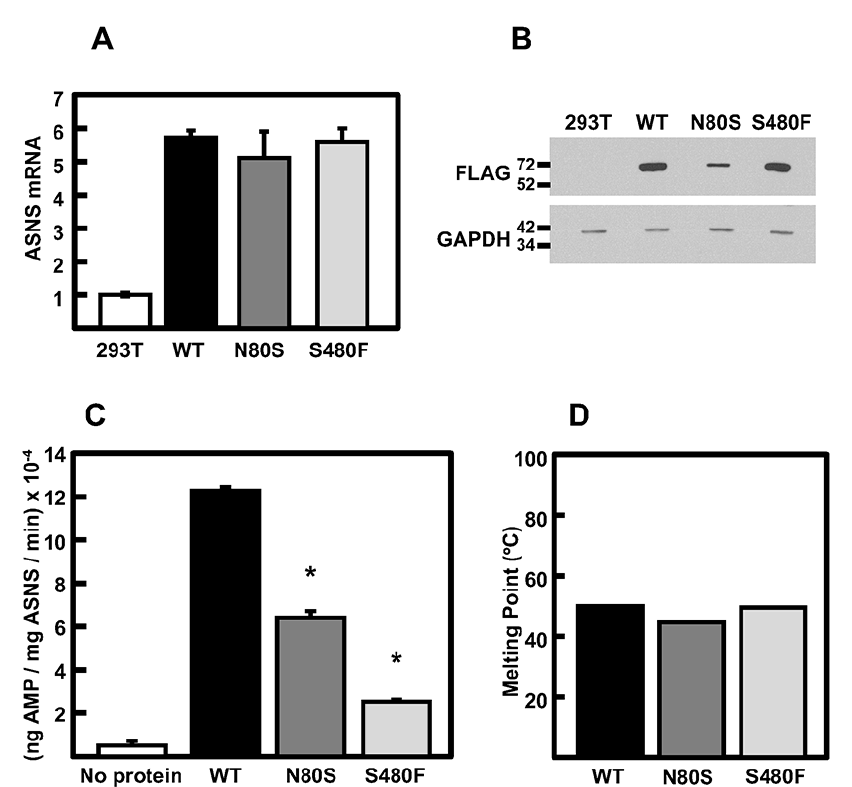
Figure 4. Enzyme activity and thermal stability of purified ASNS proteins. ( A ) ASNS mRNA levels in non-transfected HEK293T cells and in HEK293T-based cell lines stable-expressing WT, N80S, or S480F ASNS variants. The mRNA content was detected by qRT-PCR, normalized to GAPDH mRNA, and plotted relative to WT. ( B ) Immunoblot for each of the ASNS variant proteins. GAPDH protein served as the loading control. ( C ) Enzyme activity of purified WT, N80S, and S480F ASNS proteins. A reaction with no protein added serves as a negative control to show background detection. The data are the averages ± standard deviations of assays in triplicate, and an asterisk indicates that the value is statistically different from the WT with a p -value of ≤ 0.05. ( D ) The melting points of purified WT, N80S, and S480F proteins as detected by differential scanning fluorimetry.